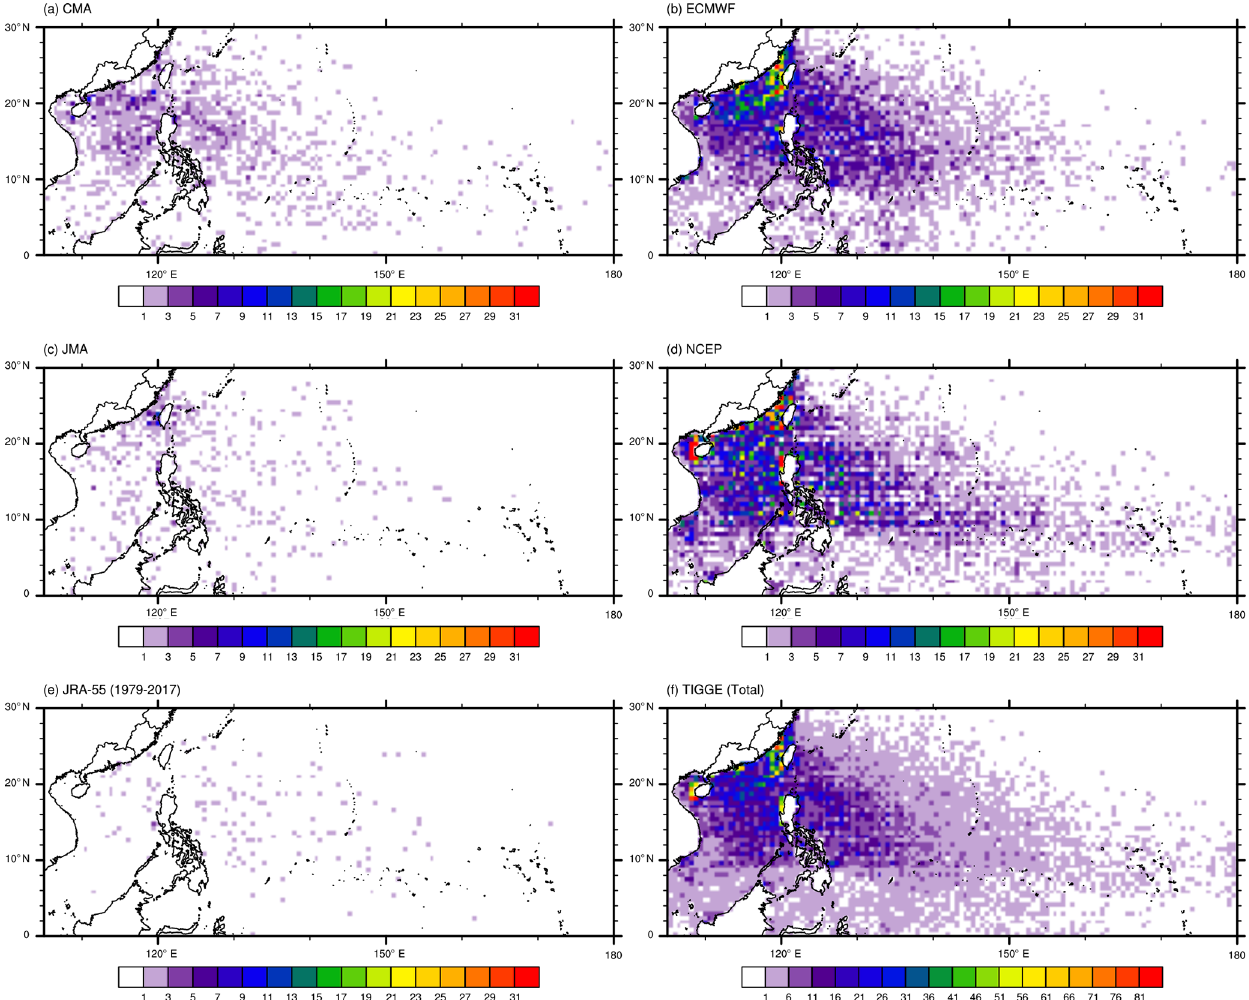
Figure 8. The spatial distribution of location of first detection of TCs (with LMIs of at least typhoon strength) which made landfall within the domain 0–30 ◦ N, 105–180 ◦ E for the TPEPS TC event set and the JRA-55 event